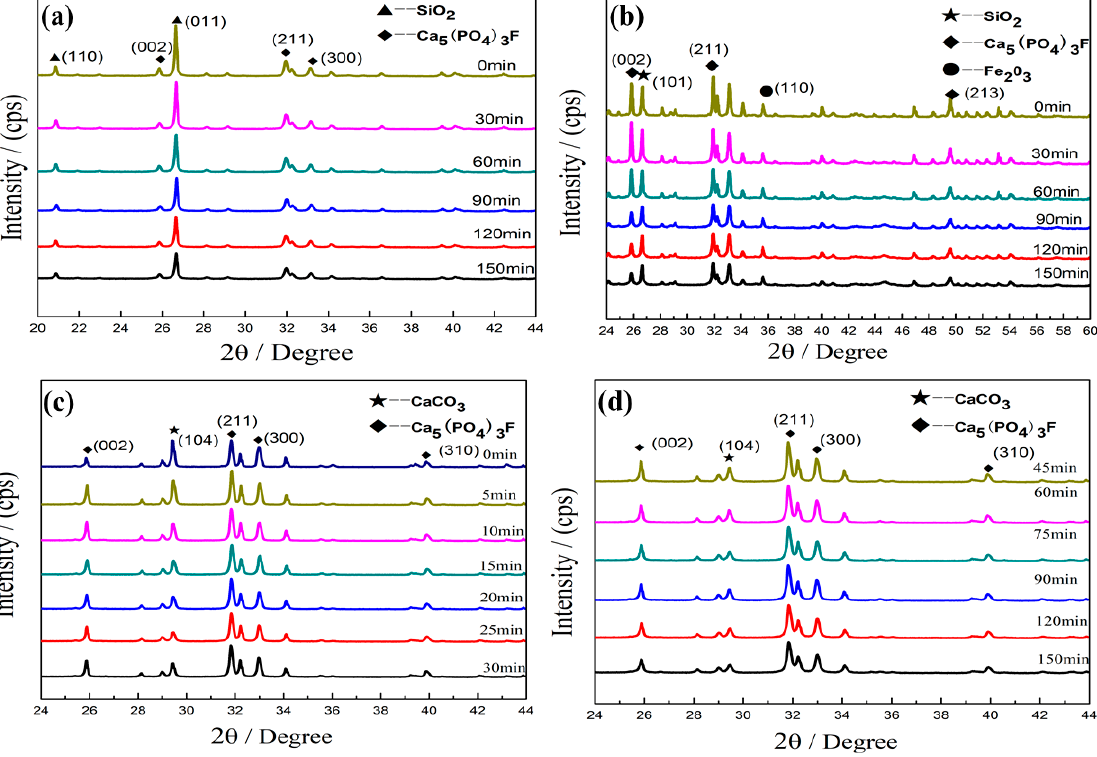
Figure 1. XRD patterns of PR at different milling times: PR1 ( a ), PR2 ( c , d ), and PR3 ( b ).